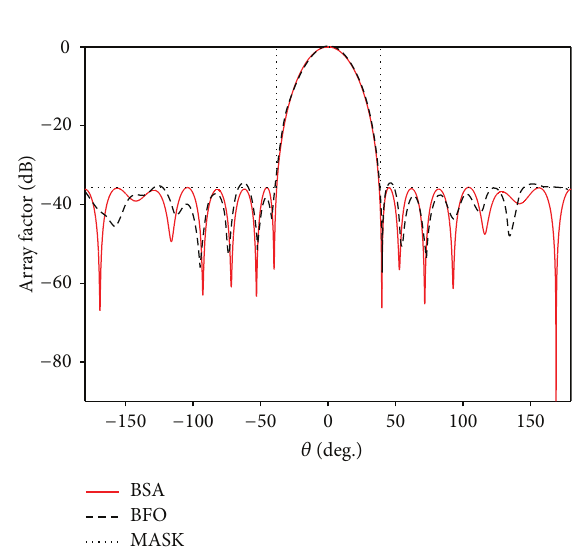
Figure 16: The radiation patterns obtained by BSA and BFO [3] for CCAA with central element